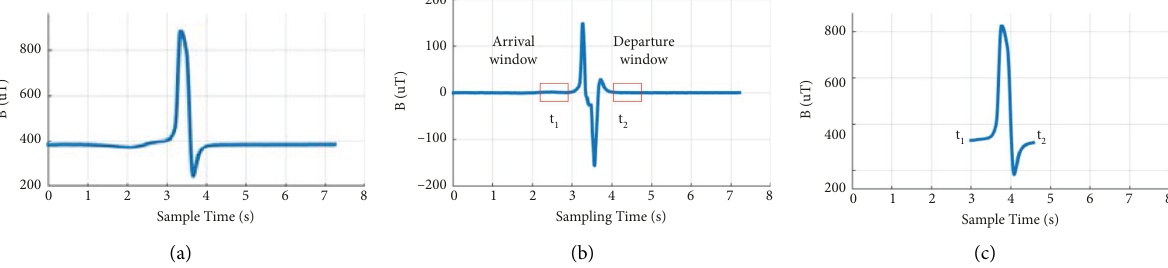
Figure 6: General view of D-DWVDA. (a) Raw waveform. (b) Waveform of differential data. (c) Extracted vehicle waveform.